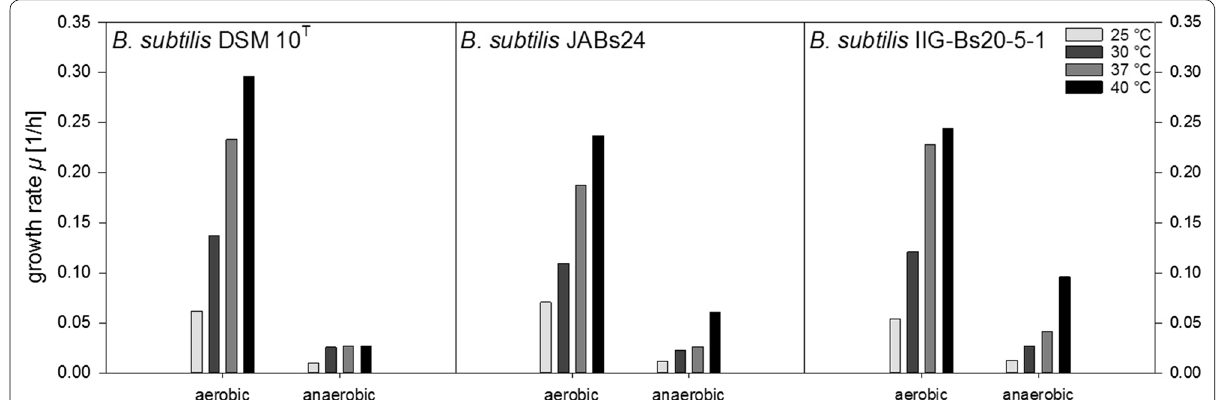
Fig. 2 Overview of the calculated growth rates µ (1/h) for strains B. subtilis DSM 10 T , B. subtilis JABs24 and B. subtilis IIG-Bs20-5-1 under aerobic and